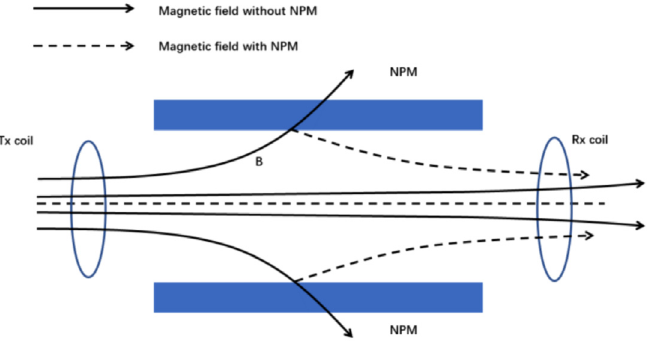
Fig. 4. Schematic diagram of ZPM Board Reducing EMF